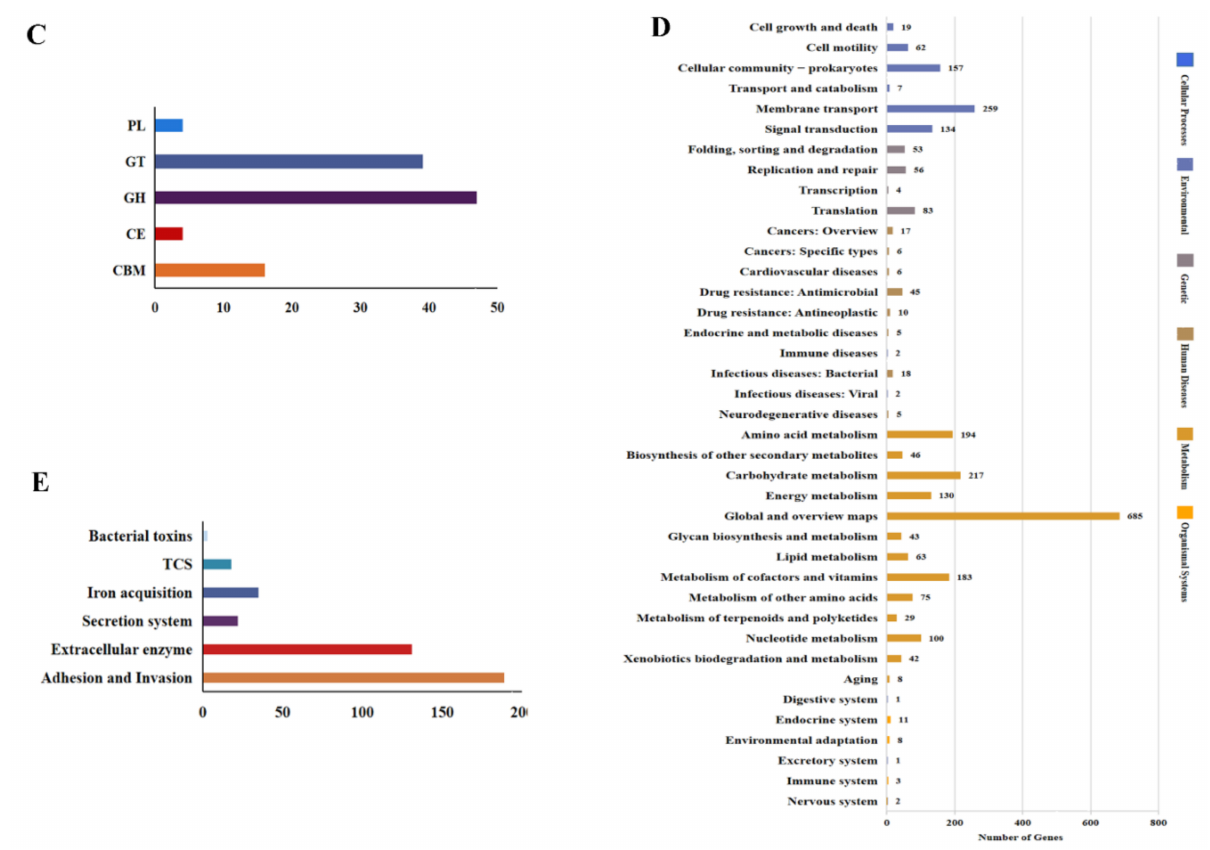
Figure 2. Functional annotation of the L. populi N-5-1 genome. Functional classifications were predicted using the COG ( A ), GO ( B ), carbohydrate-active enzyme (CAZy) ( C ), and Kyoto Encyclopedia of Genes and Genomes (KEGG) ( D ) databases. ( E ) According to the Virulence Factors of Pathogenic Bacteria (VFDB) database, the six virulence factor categories were adhesion and invasion, the secretion system, extracellular enzyme, bacterial toxin, the two-component system, and iron